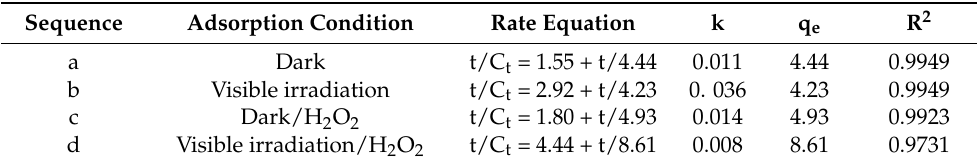
Table 1. Results from linear regression of pseudo-second-order equation plots of n-hemin/PAN. Sequence Adsorption